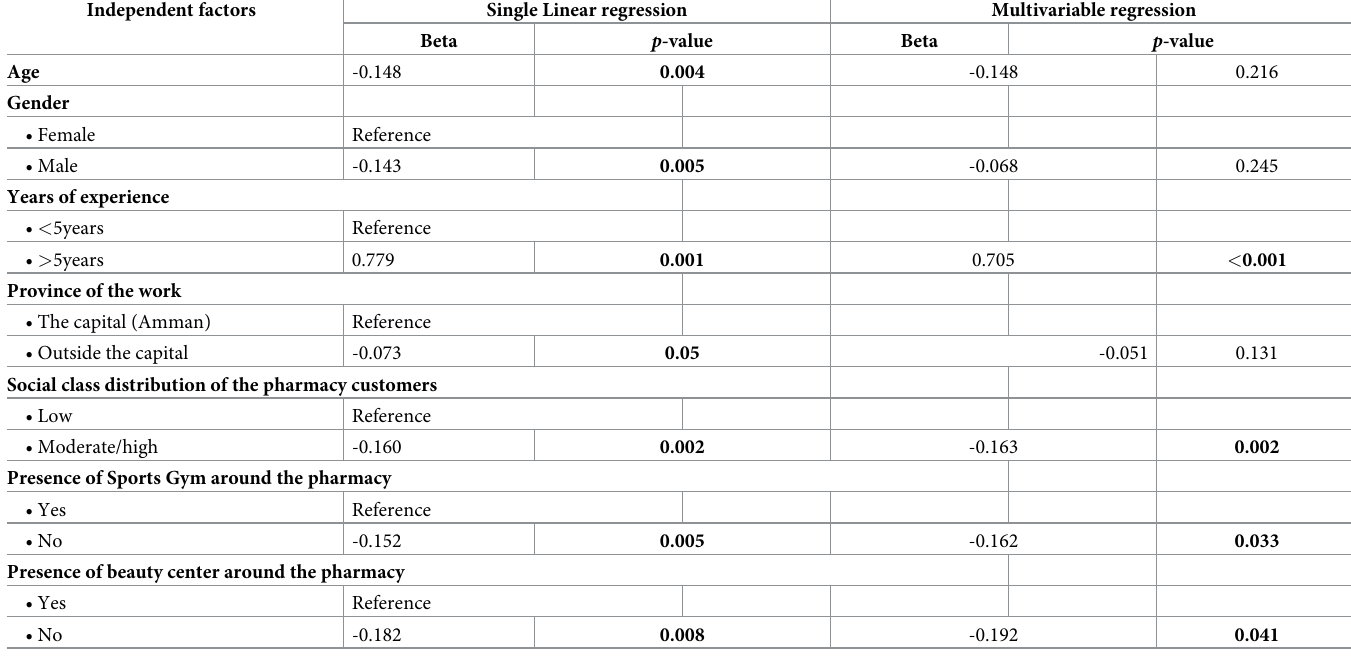
Table 4. Summary of the linear regression analysis (single and multivariant) to assess factors associated with the exposure of participating pharmacists to OCPs improper use